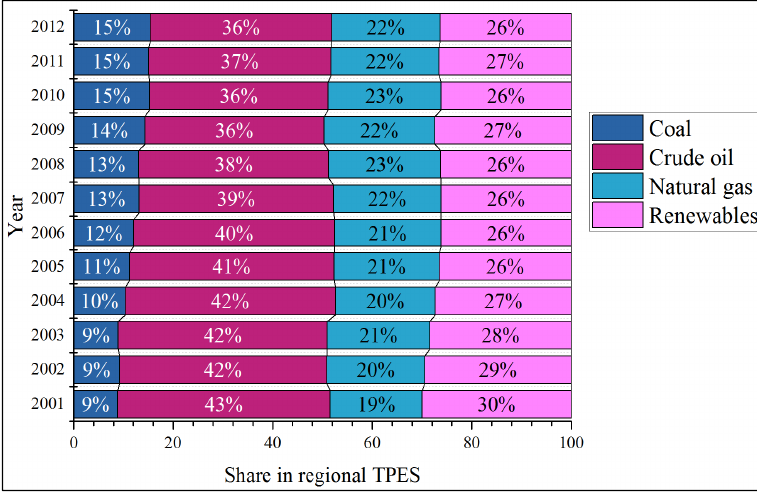
Figure 10. ASEAN primary energy supply between 2001 and 2012 (by